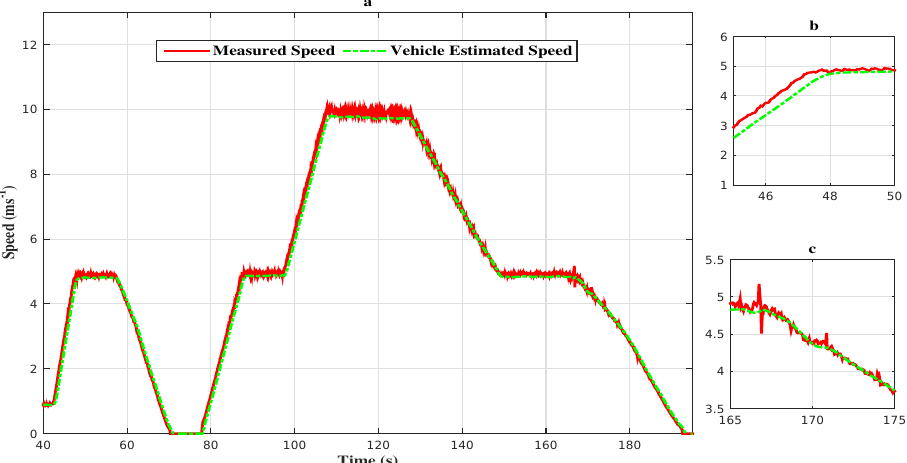
Figure 8. ( a ) Speed profile of the vehicle with the proportional and integral observer closed loop FTC. ( b ) Zoom in at t ∈ [ 45 s,50 s ] . ( c ) Zoom in at t ∈ [ 165 s,175 s ]